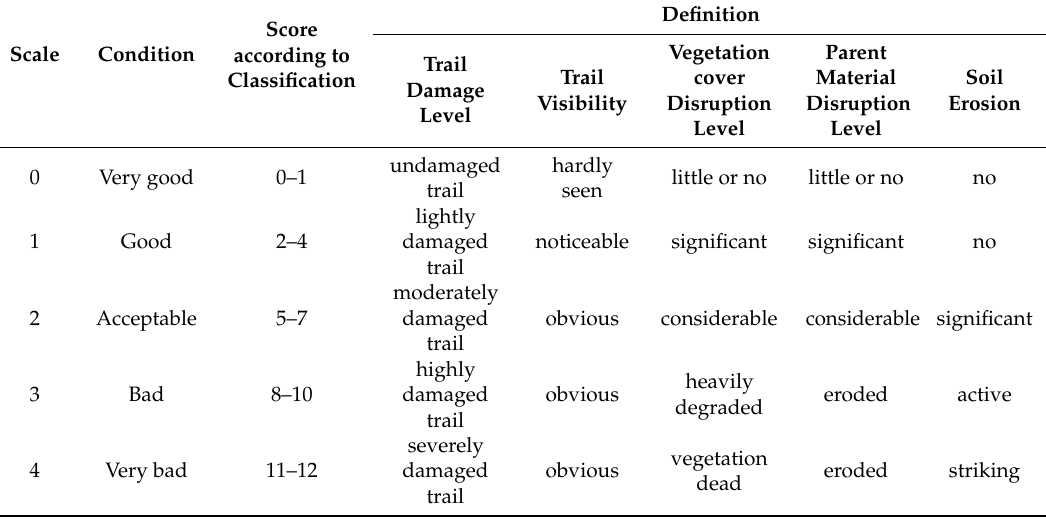
Table 1. Condition scale for hiking trails used in this study, which was adapted from the description in